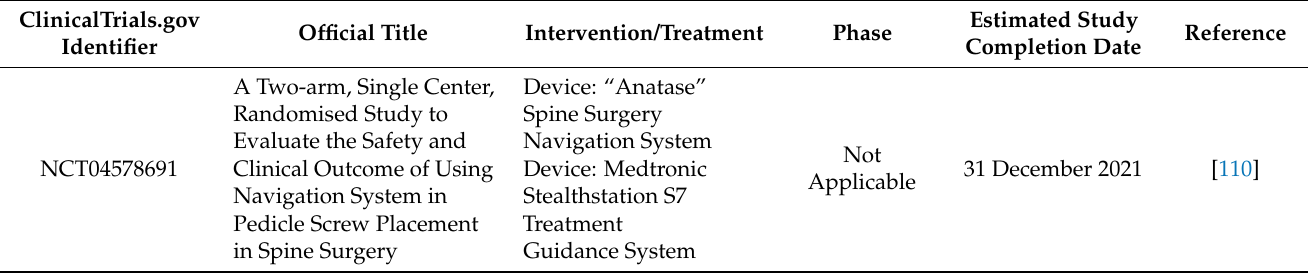
Table 4. Summary of active clinical studies concerning spine tumors. Information retrieved from Clin- icalTrials.gov using the following search constraints: “Spine tumor”–Recruiting; Not yet